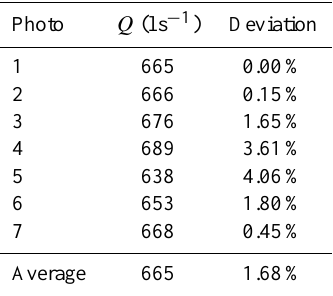
Table 3. Discharges measured in the river Sˆure (10 May 2011); the absolute deviations are relative to the average discharge measured with the rising bubble technique.